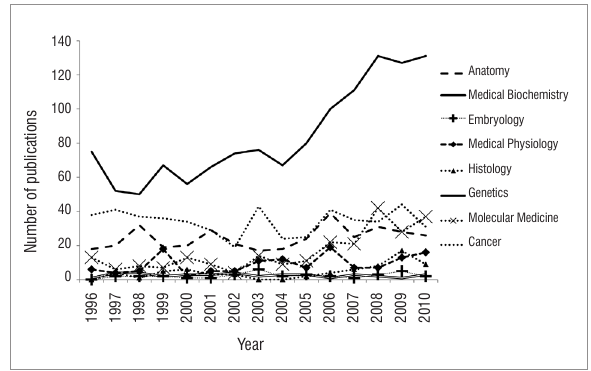
Number of publications from South Africa in Basic and Pre- clinical Science disciplines during 1996–2010.